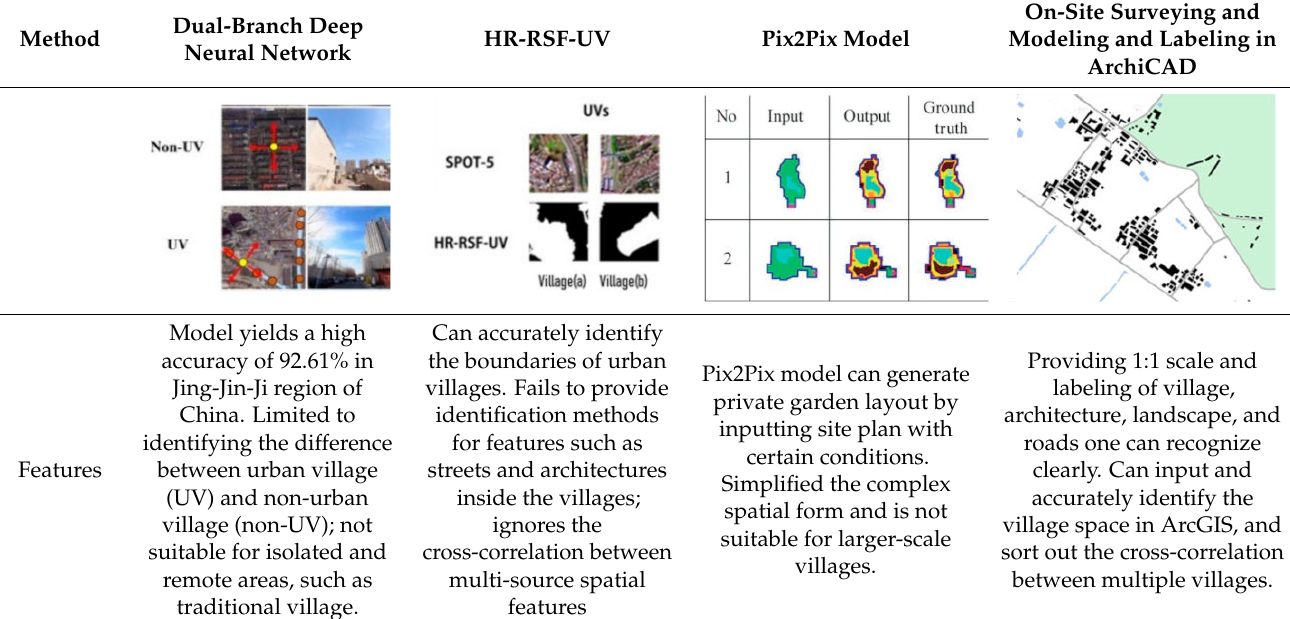
Table 2. The different methods to recognize villages: edited by